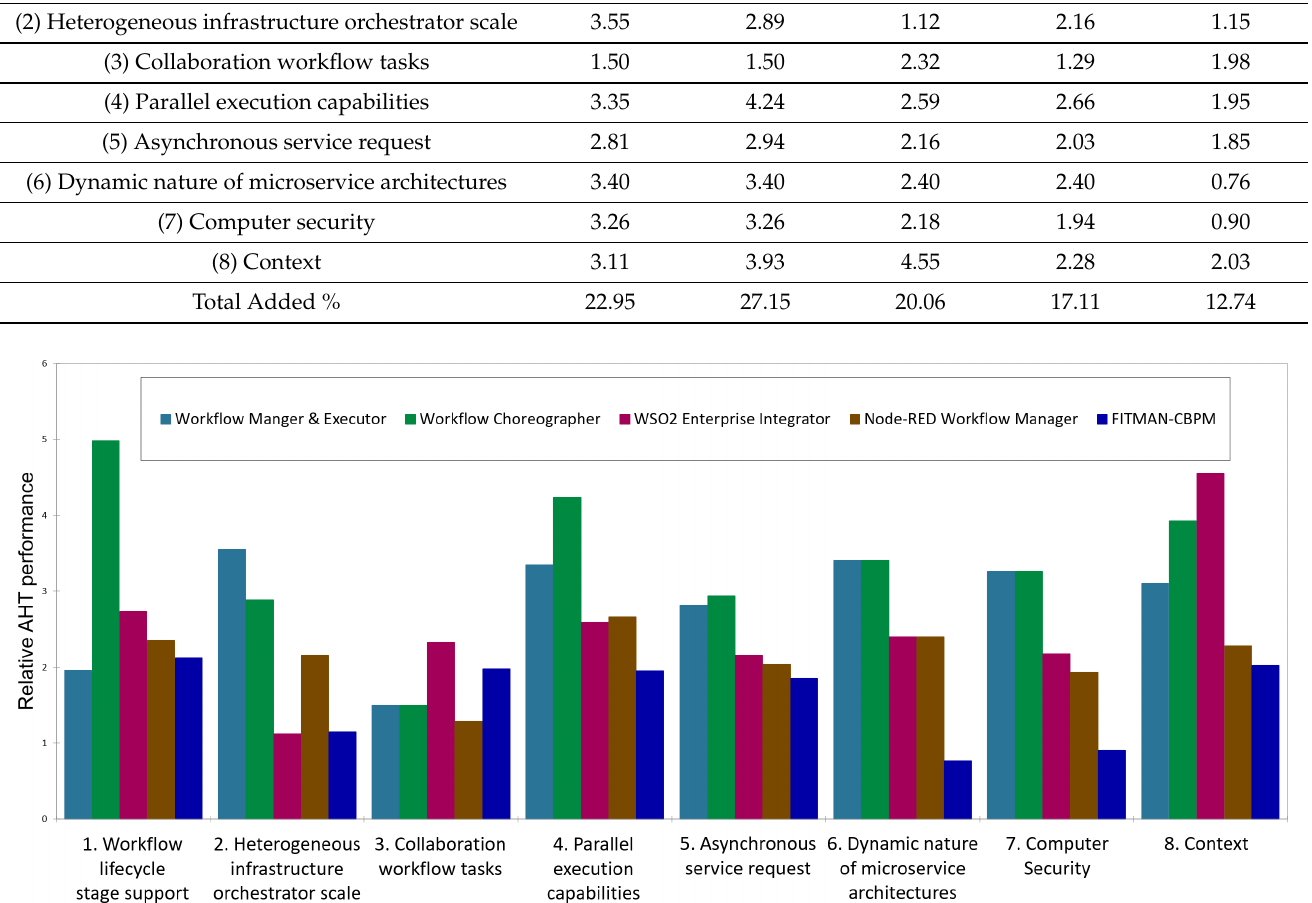
Figure 8. The results of the AHP alternative selection analysis selection for the microservice-based workflow management and execution